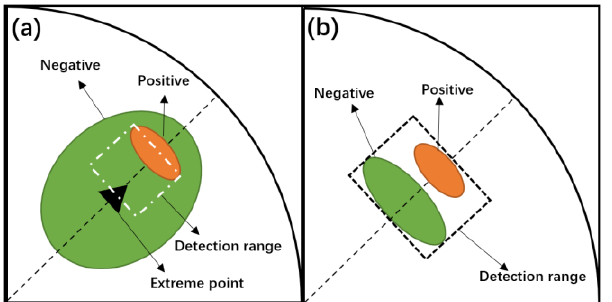
Figure 5. Detection range of the zero Doppler velocity line. ( a ) Detection range of the zero Doppler velocity line with large and small circles; ( b ) Detection range of the zero Doppler velocity line with two adjacent circles.